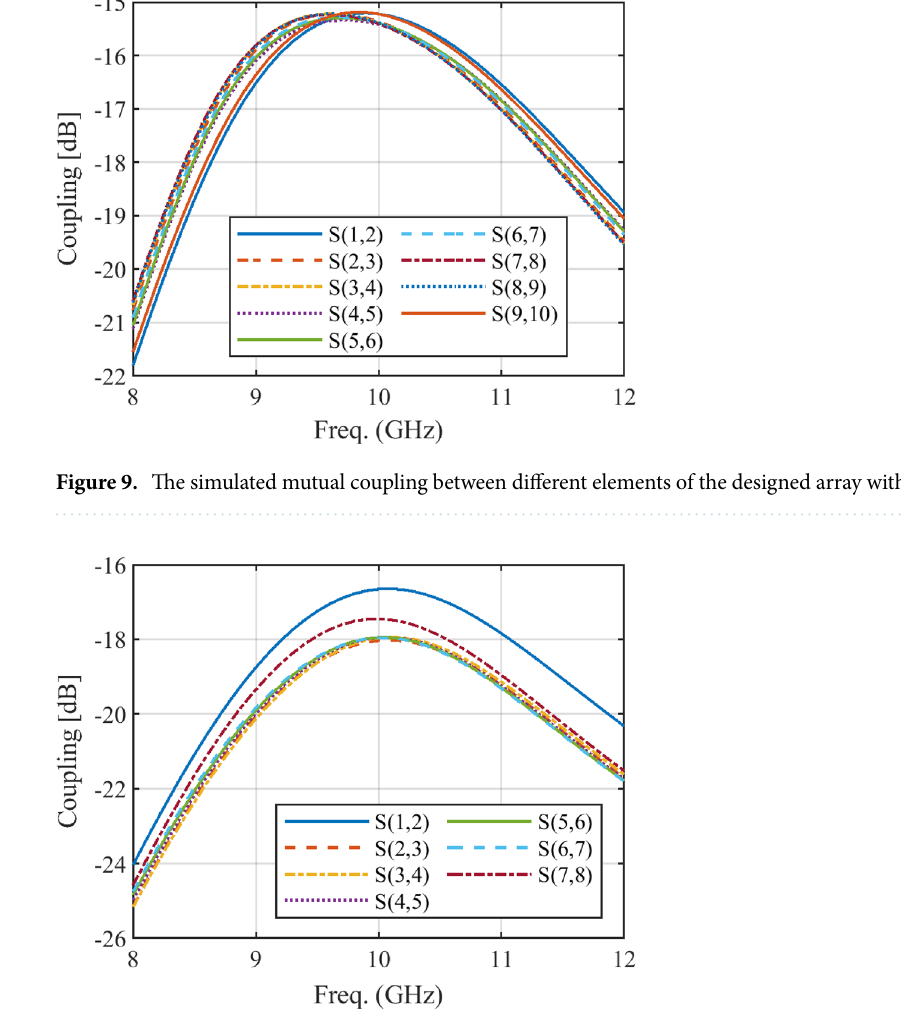
Figure 10. The simulated mutual coupling between different elements of the designed array with the proposed